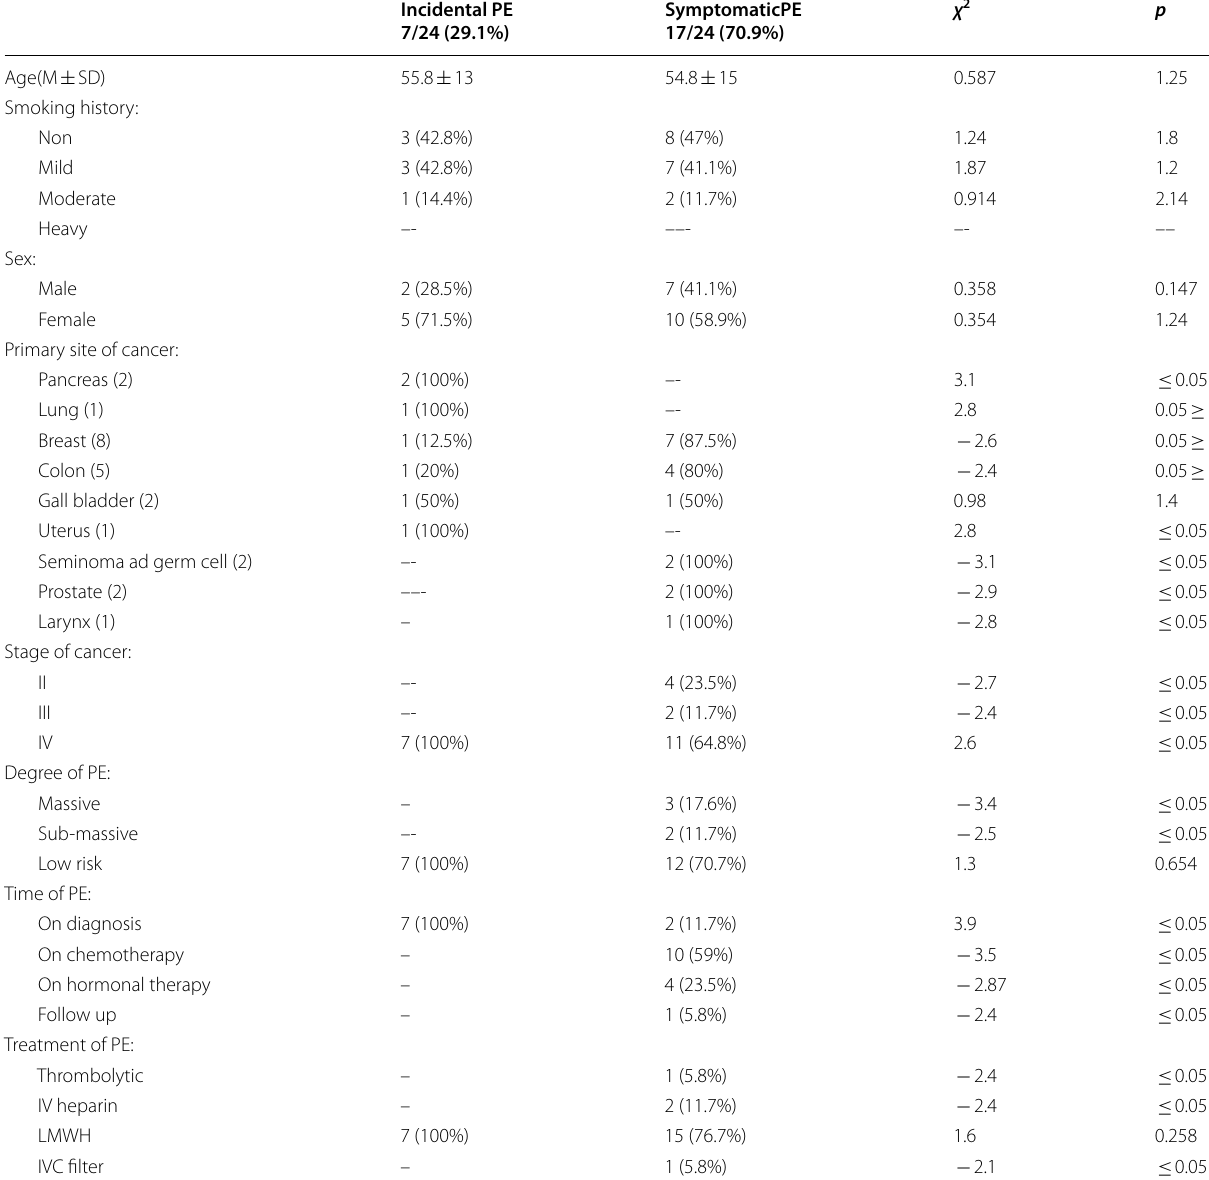
PE pulmonary embolism, Ca cancer, IV heparin intravenous heparin, LMWH low molecular weight heparin, IVC filter inferior vena cava